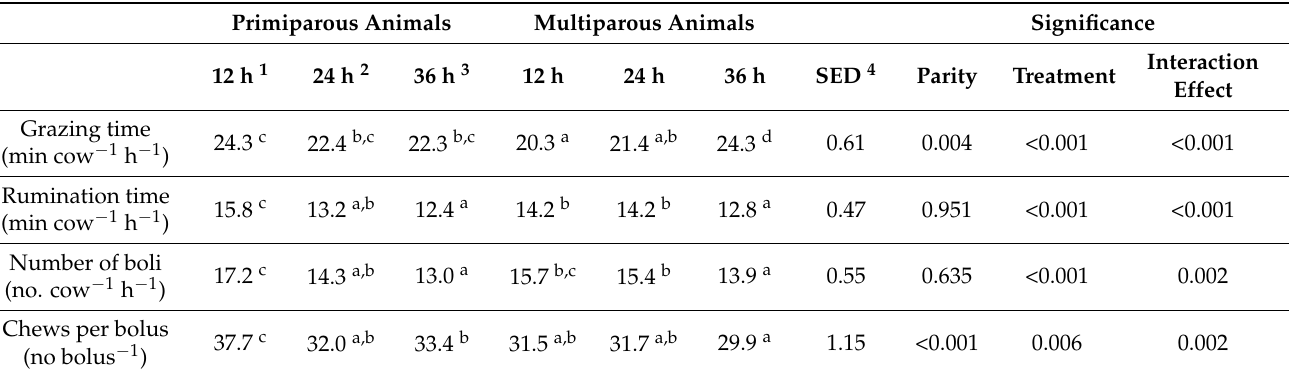
Table 2. The effect of parity, pasture allocation frequency and interaction effects on animal grazing and ruminating